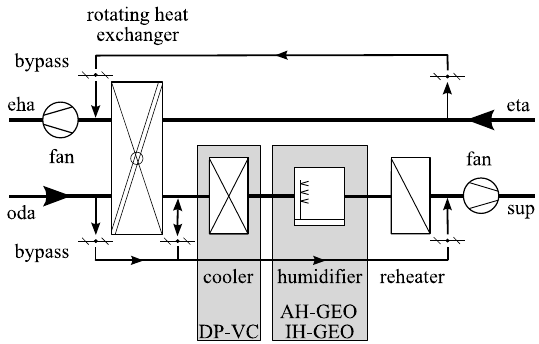
Figure 11. Specific layout of air handling units for different reference systems.